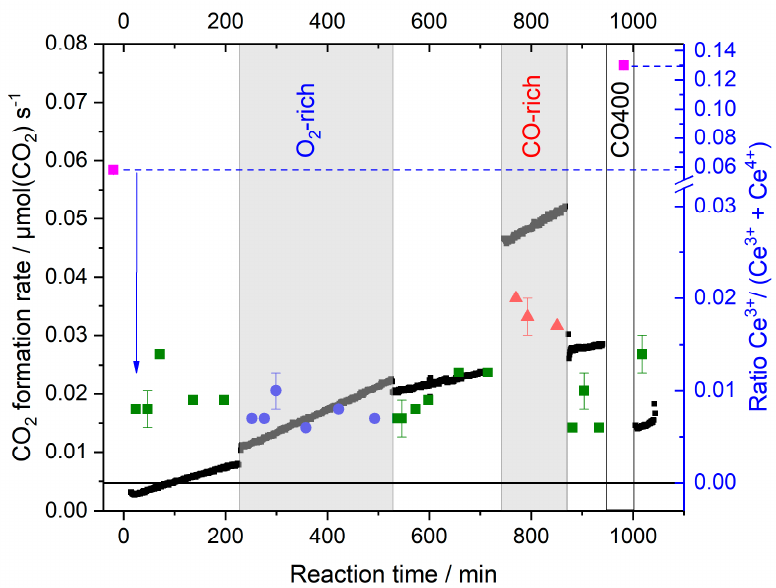
Figure 6. Formation rate during CO oxidation in di ff erent reaction atmospheres (standard, O 2 -rich, CO-rich) at 80 ◦ C on a Au / CeO 2 catalyst after reductive (CO400) pretreatment in 10% CO in N 2 at 400 ◦ C (black circles) and the relative Ce 3 + content during time on stream as extracted from linear combination analysis (LCA) analysis of operando X-ray absorption spectra recorded in fluorescence mode during reaction (blue, green, and red symbols). Representative error bars are shown for each sequence.